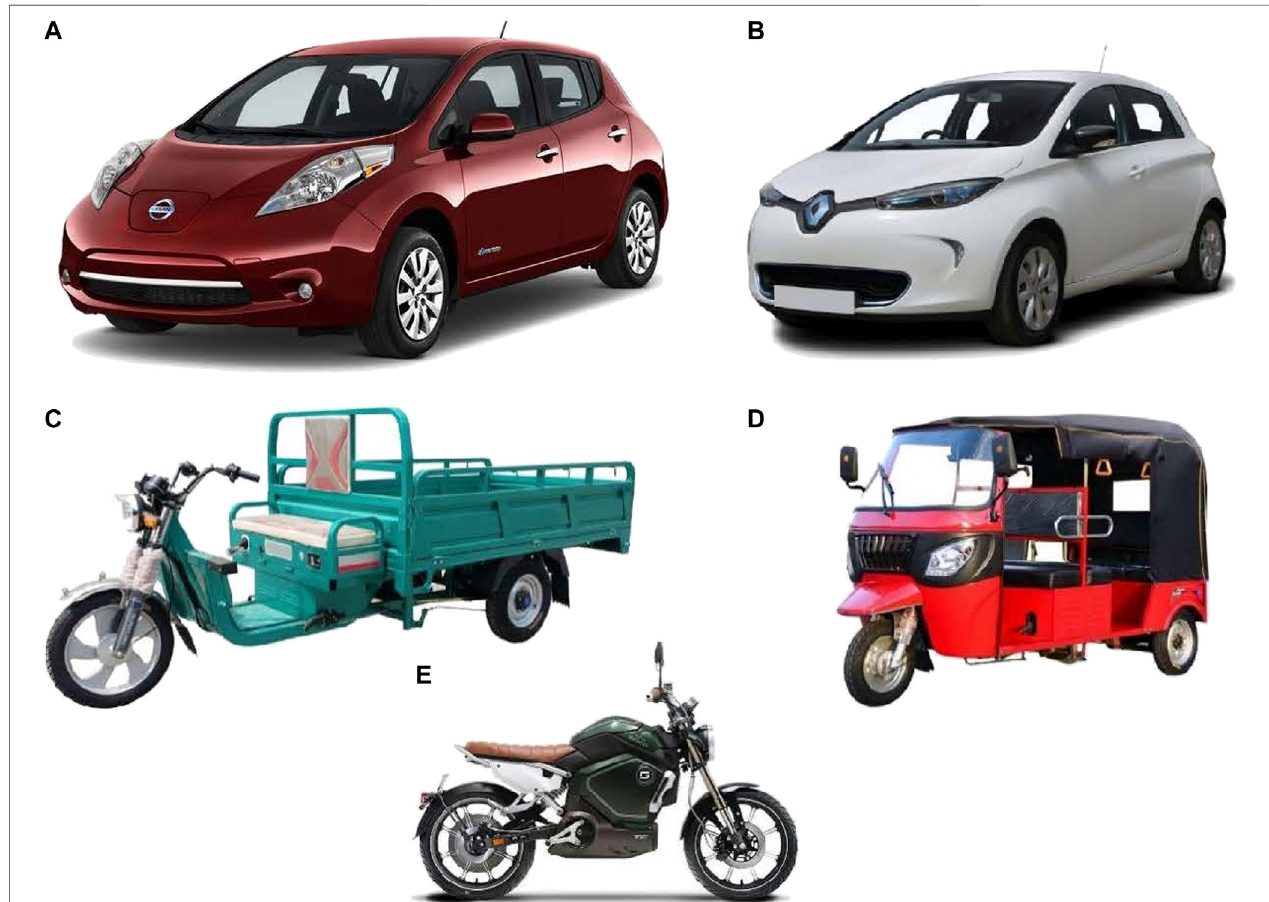
FIGURE 10 | Illustration of vehicles being assessed as alternatives to the Nissan e-NV200 minivan used in the Solar Taxi fi eld trial (Source: Nissan, 2017; Renault, 2016;HenanZipstarTricycleManufacturingCo.Ltd.,2020;XinxiangSiristarImportandExportCo.Ltd.,2020;VmotoUnitedKingdomDistributionLtd.,2019;usedwith